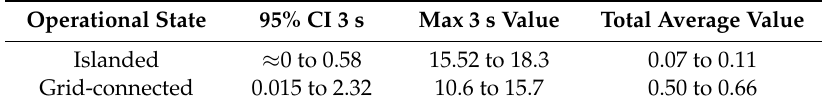
Table 8. 95% confidence interval, the maximum 10 min value and total average value for all three phases in islanded and grid-connected